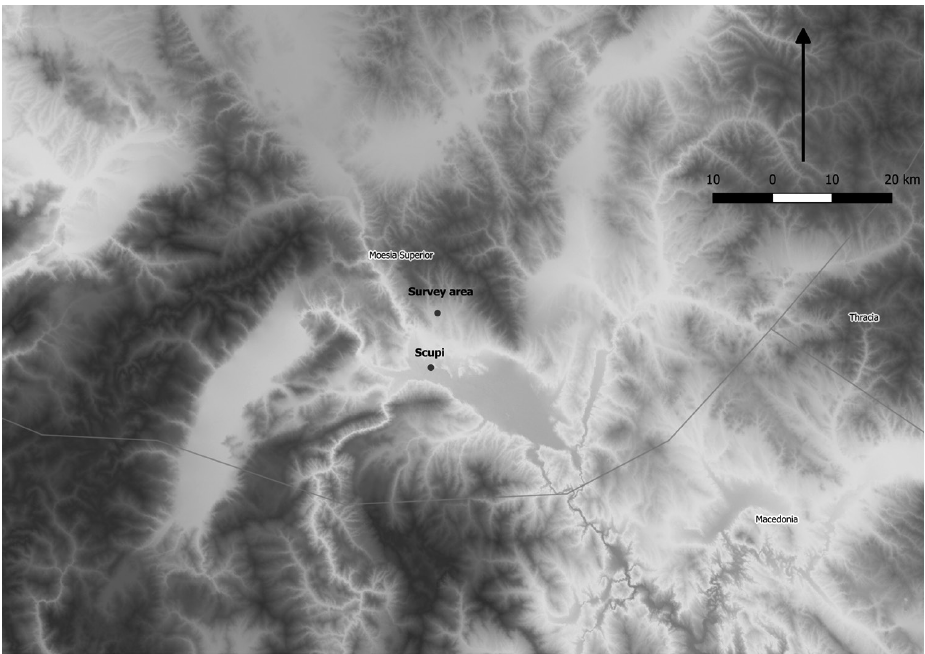
Figure 3: The survey area and the location of